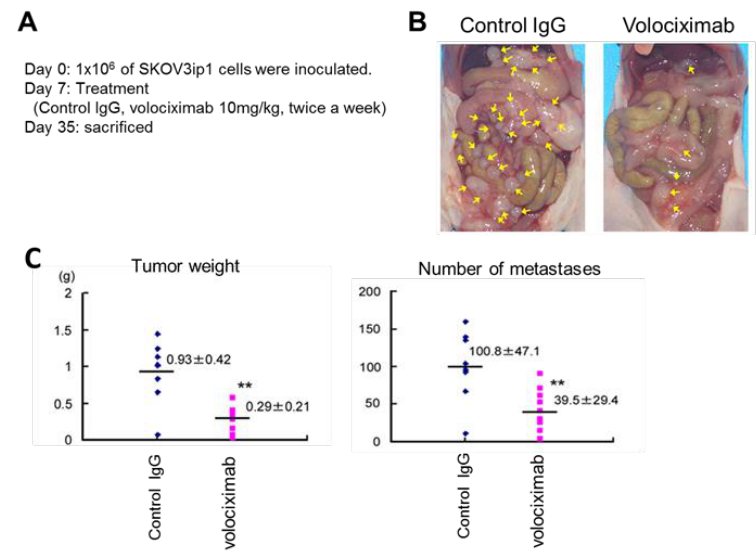
Figure 2. Blocking of α5β1-integrin (by volociximab) inhibits tumor metastasis in a xenografted model [42]. ( A ) Protocol: 1 × 10 6 SKOV3ip1 cells were intraperitoneally injected into Balb-c female nude mice. The mice were randomized into two groups containing 10 mice each and were treated with 10 mg/kg volociximab or control IgG twice a week. On day 35 after the injection, the mice were sacrificed. ( B ) Representative images of each group. ( C ) Tumor weight (left) and number of tumor metastases are shown (** p < 0.01).